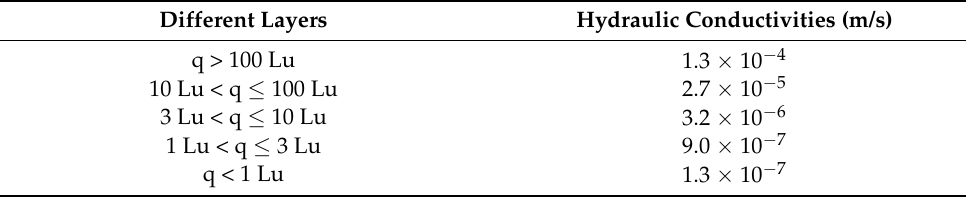
Table 5. Hydraulic conductivities of different layers of the rock-soil body.